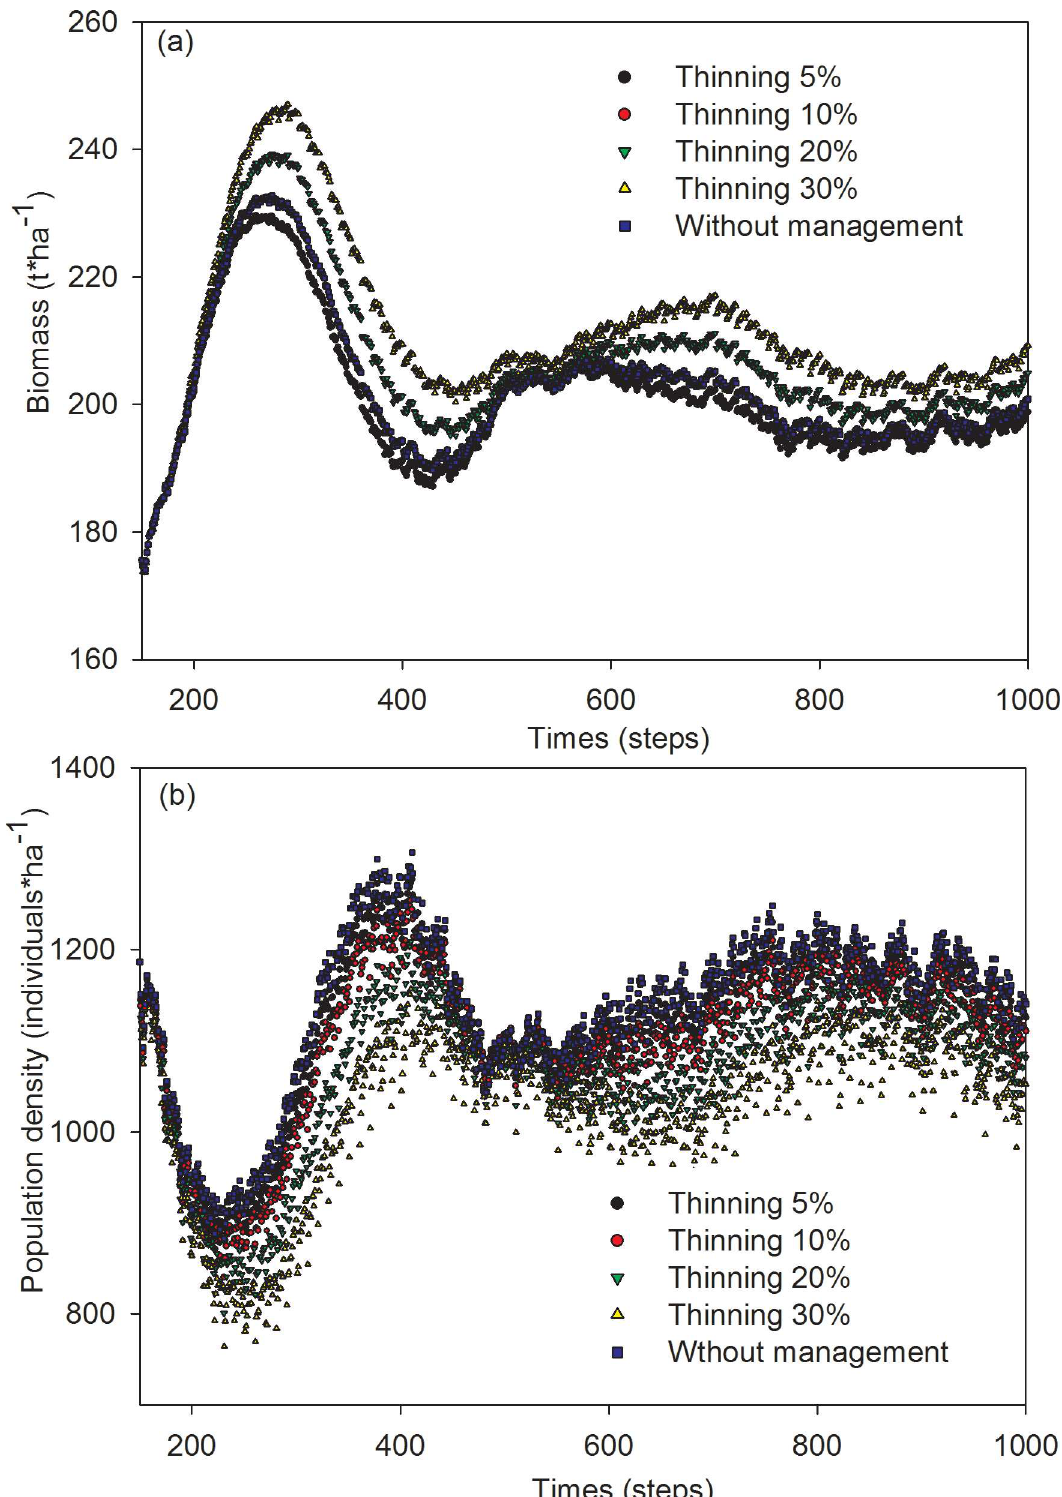
Fig 5. Simulationresults of the effects of thinningon biomass (a) and populationdensity (b) of juveniletrees in Mongolian pine